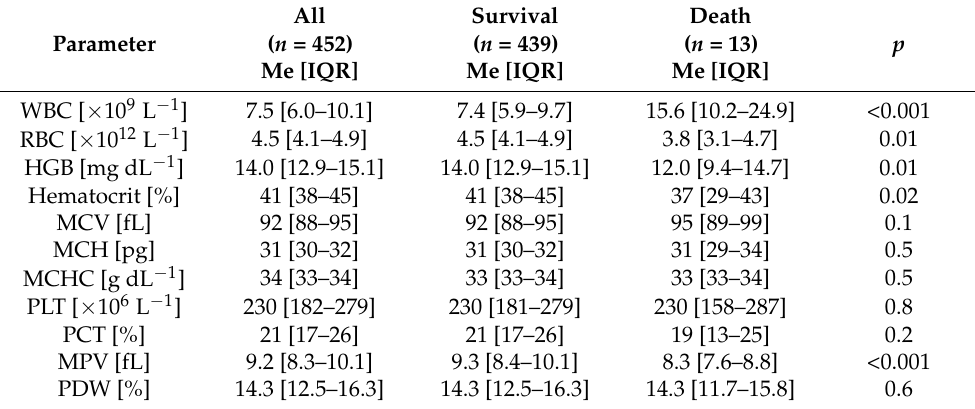
Table 2. Selected peripheral blood morphological parameters evaluated preoperatively.